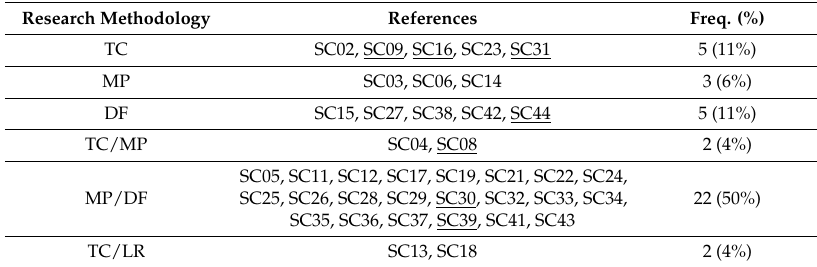
Table 3. Frequency analysis findings regarding type of research methodology.